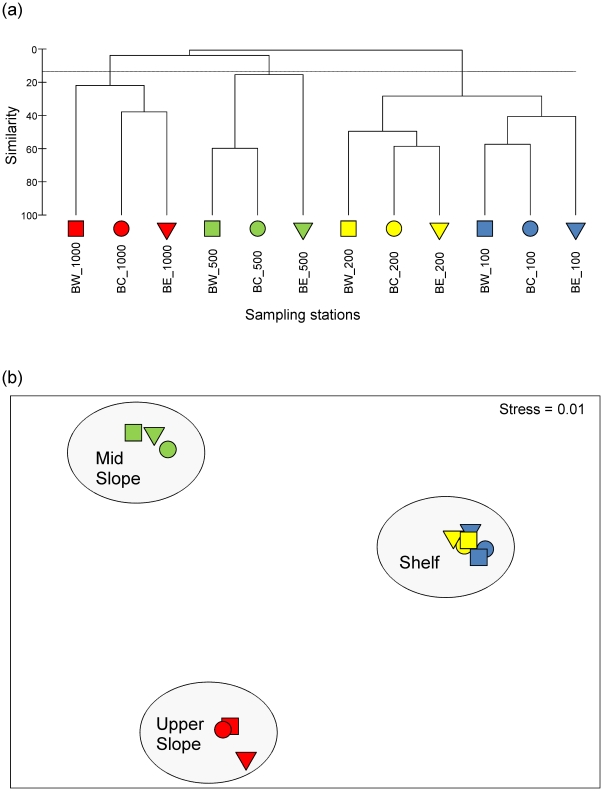
Dendrogram and non-metric MDS ordination of demersal fish community structure at 12 depth-stratified sampling stations located around the head of Bonney Canyon.Transects relative to the main canyon axis are represented by different symbols (squares = west, circles = centre, triangles = east), and depths by different shades of fill (white = 100 m, light grey = 200 m, dark grey = 500 m, black = 1000 m). Three station groupings are identified from the SIMPROF permutation test at the 5% significance level (dotted line): shelf, upper slope and mid slope.